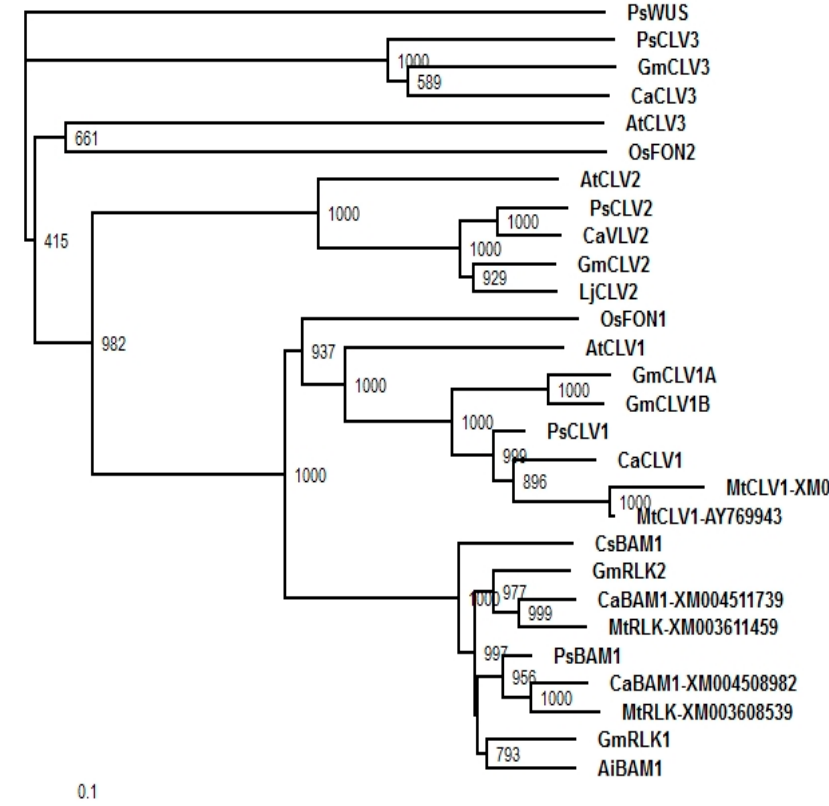
Figure 2. Neighbor Joining phylogenetic tree for BAM1 and CLV protein sequences in P. sativum L. and related species. Bootstraps values were generated with 1000 bootstrap replicates. The tree was rooted using the PsWUS protein sequence.